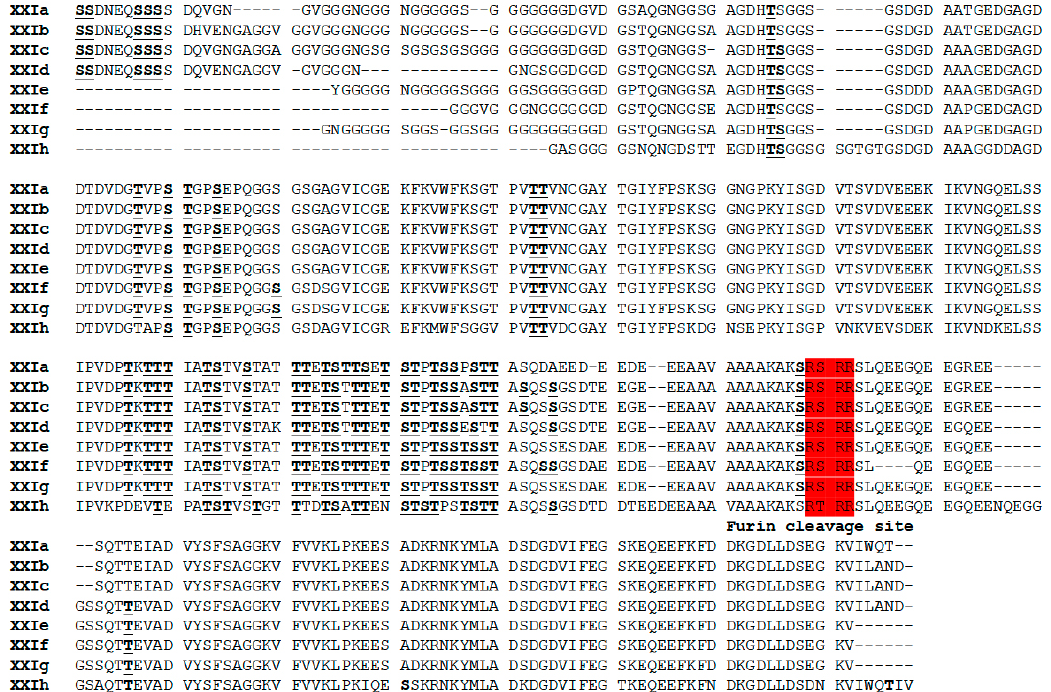
Figure 3. Deduced amino acid sequences of the partial gp60 gene of eight subtype families (XXIa to XXIh) in Cryptosporidium ryanae . Predicted O-linked glycosylation sites are indicated in boldface and underlined type. The classic furin proteolytic cleavage site sequence RSRR / RTRR is shown in red. Dashes denote amino acid deletions.